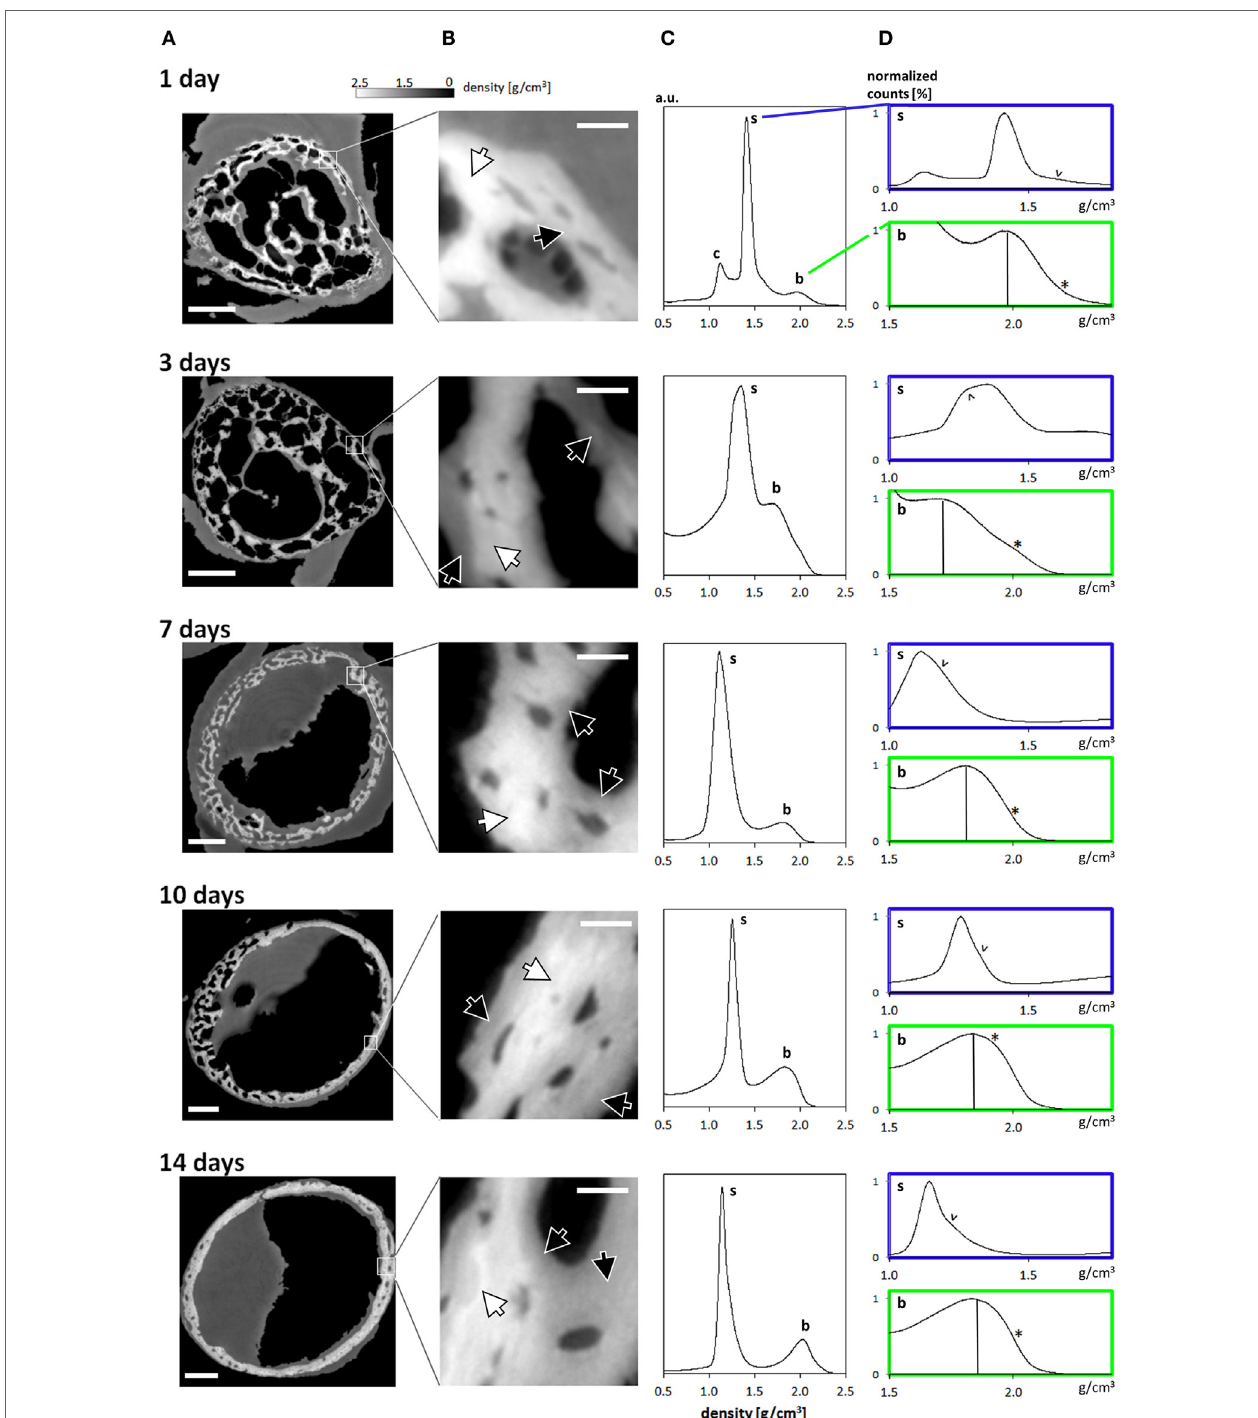
FigUre 2 | (a) Typical cross-sections through femur midshafts of 1, 3, 7, 10, and 14 days old mouse bones (scale bar = 200 μ m). The gray values are scaled to mass density (g/cm 3 ). (B) Insets show higher magnifications of the developing bone (scale bar = 20 μ m). For clarity, the contrast is enhanced. White arrows highlight regions of highly mineralized bone, and black arrows point to low mineral regions. (c) Mass-density histograms of typical 3D datasets (more than 10 9 values per scan) exhibiting a prominent peak of the soft tissue, a range of intermediate densities, and a shoulder depicting highly mineralized bone. (D) Magnified regions in each histogram in (B) limited to the soft tissue (s) and the bone peak (b). Within the soft tissue comprises different densities [marked by arrowheads (v)] owing to the extended holotomography density sensitivity. Vertical lines in the bone panels mark the position of the bone peak. Note the presence of substantial amounts of high mineral density bone (indicated by